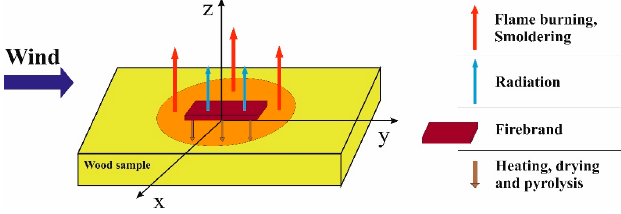
Figure 1. Process diagram.